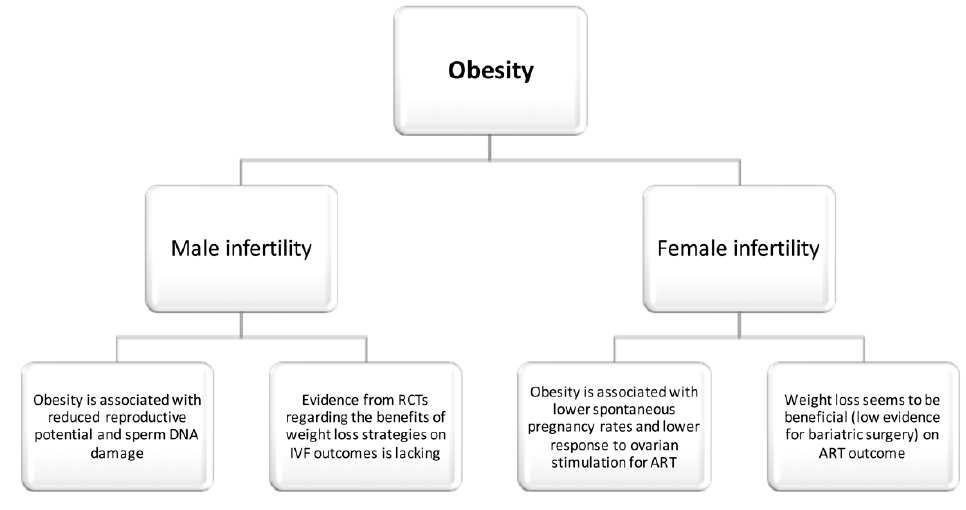
Figure 1. Obesity and infertility.